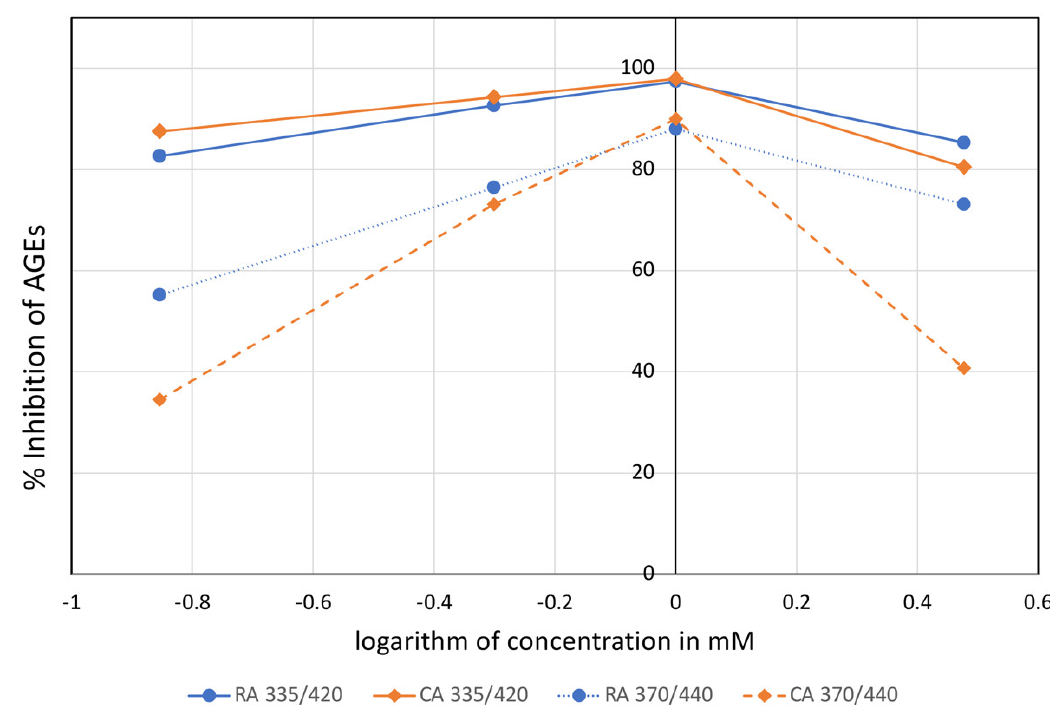
Figure 4. The % inhibition of pentosidine-like (370/440) and vesperlycine-like (335/420) AGEs by rosmarinic acid (RA) and carnosic acid (CA) in a concentration range of 0.14 to 3.00 mM.